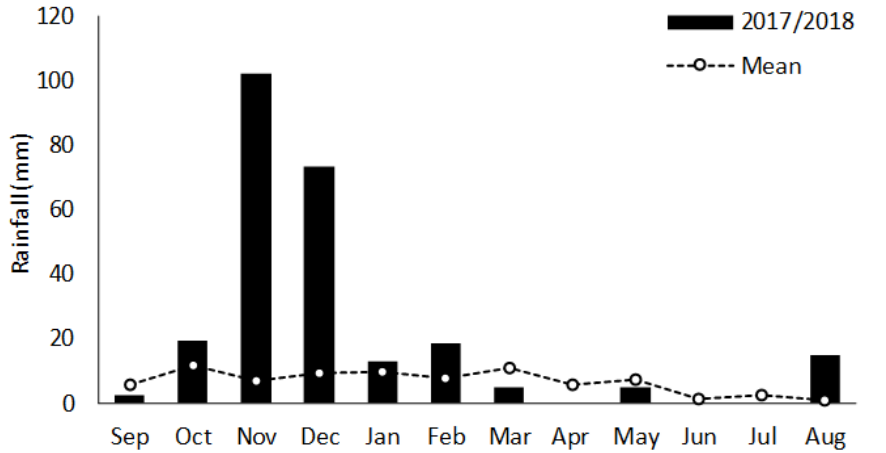
Figure 2. Annual and monthly rainfall variability during the season of 2017/2018 in Tataouine, southern Tunisia [26].